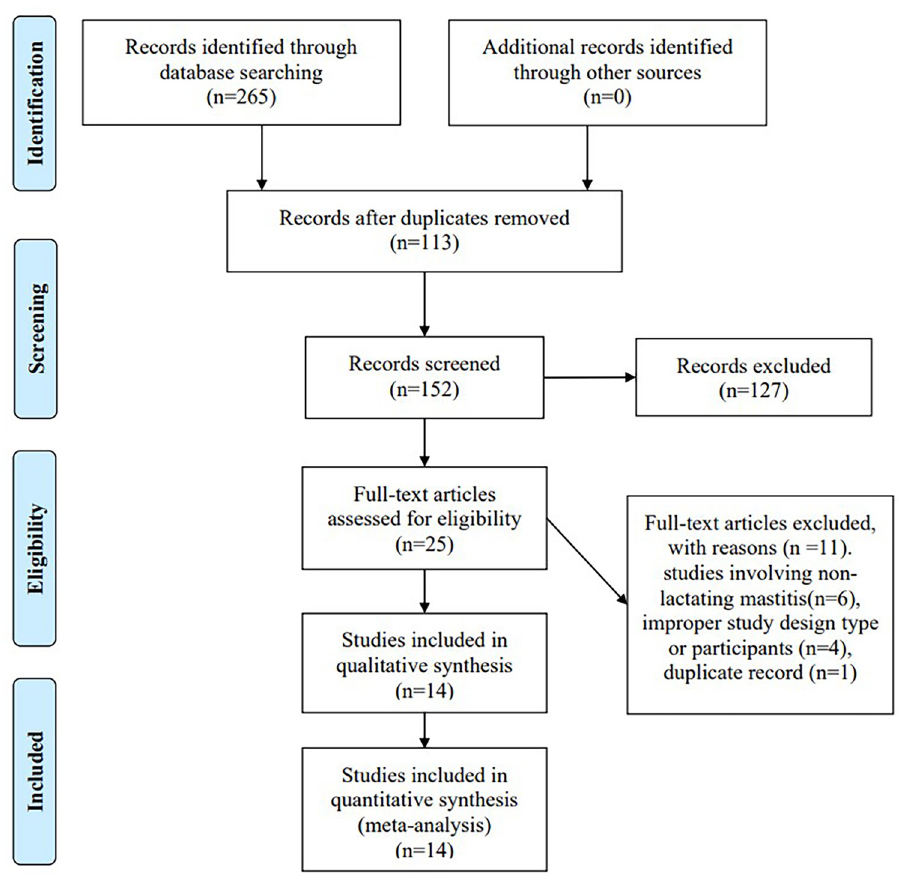
Fig 1. Flow diagram of the literature search and selection